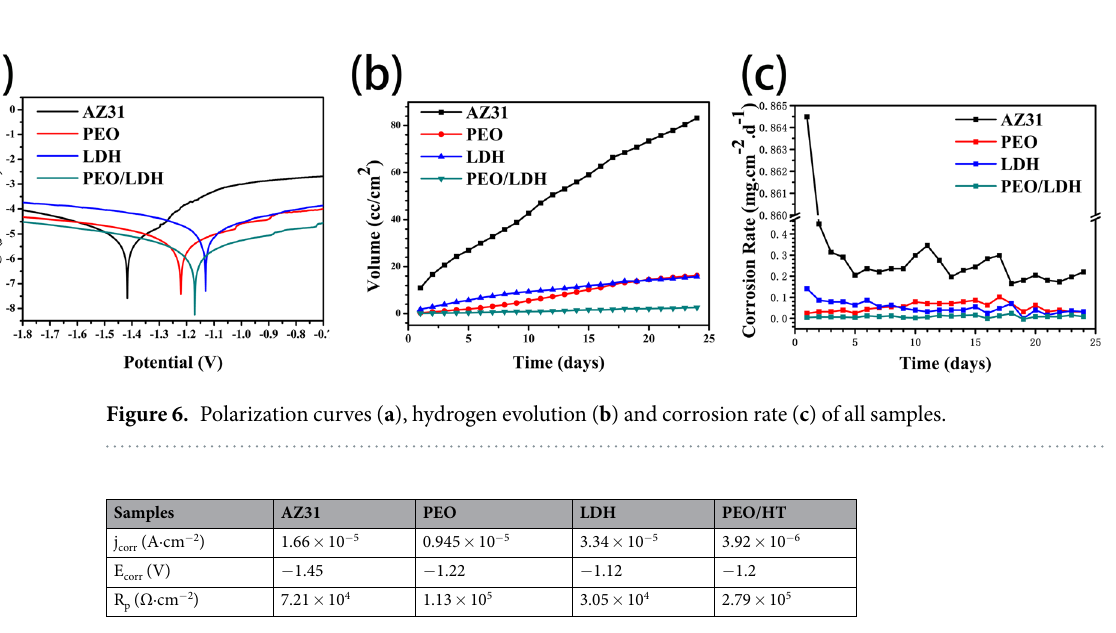
Table 2. Corrosion potential (E corr ), corrosion current density (i corr ) and polarization resistance (Rp) calculated according to the polarization